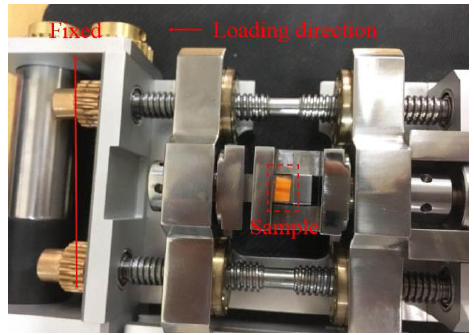
Figure 3. The in situ compression test equipment. Table 1. The parameters of resin material provided by manufacturers.